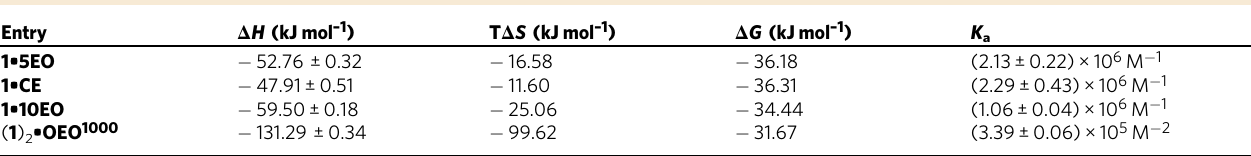
Thermodynamic parameters ( Δ H and T Δ S ) and binding constants ( K a ) for the formation of 1 (cid:129) 5EO , 1 (cid:129) CE , 1 (cid:129) 10EO , and ( 1 ) 2 (cid:129) OEO 1000 obtained by ITC experiments (H 2 O,